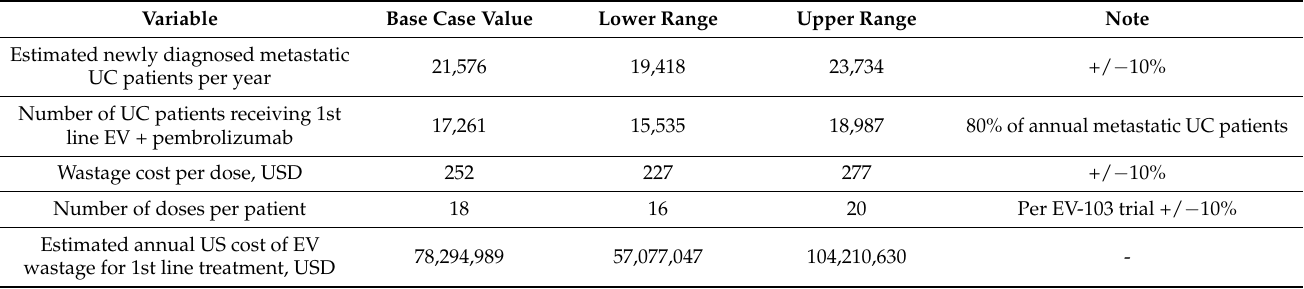
Table 3. Structural sensitivity analysis of EV as 1st